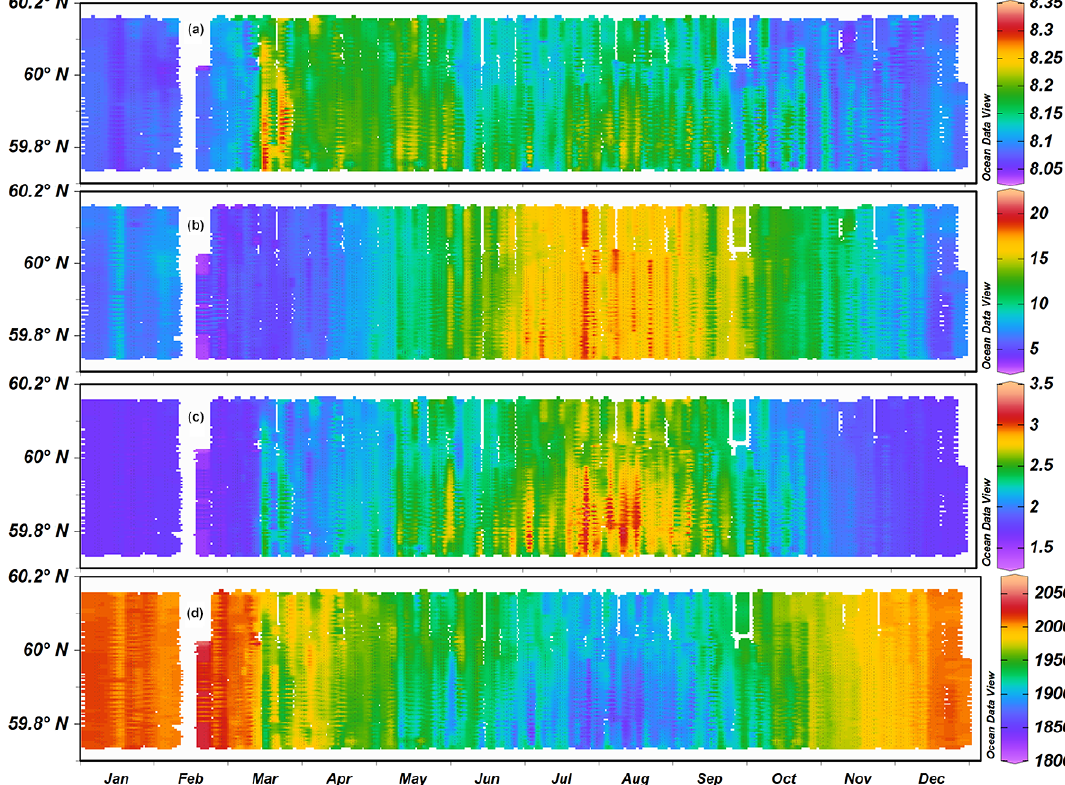
Figure 3. (a) Estimated pH(sst), (b) UW SST, (c) estimated (cid:127) Ar (sst), and (d) estimated DIC, which have been normalized to the mean salinity of 30.5 as a function of latitude and time of the year. All data from 2005 to 2009 have been condensed into one virtual year to resolve the spatial and seasonal